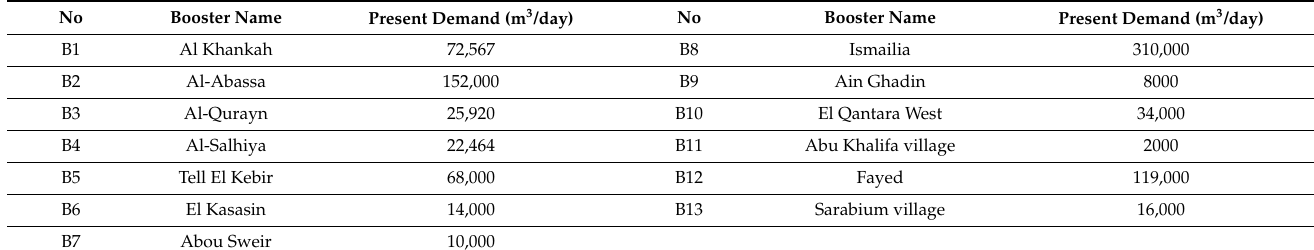
Table 3. Present domestic demand for the thirteen water boosters in the study area [47,48].